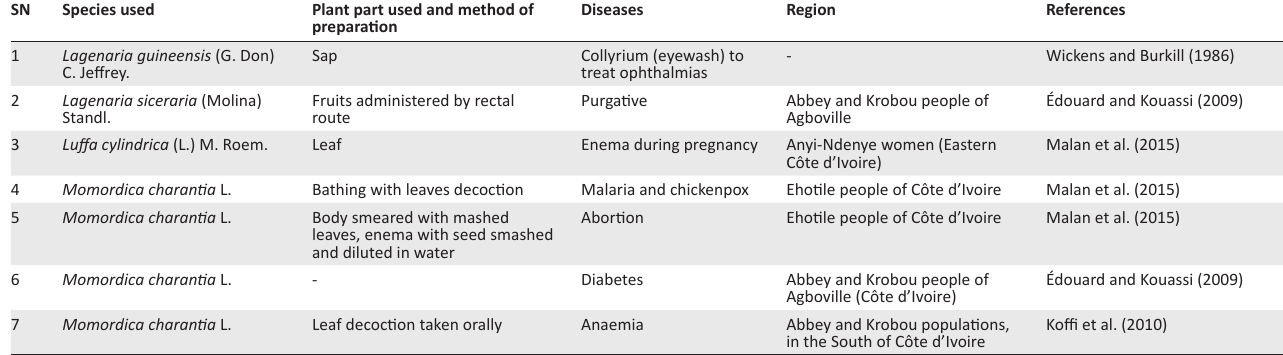
TABLE 4: Cucurbitaceae species used as traditional medicine in Côte d’Ivoire.